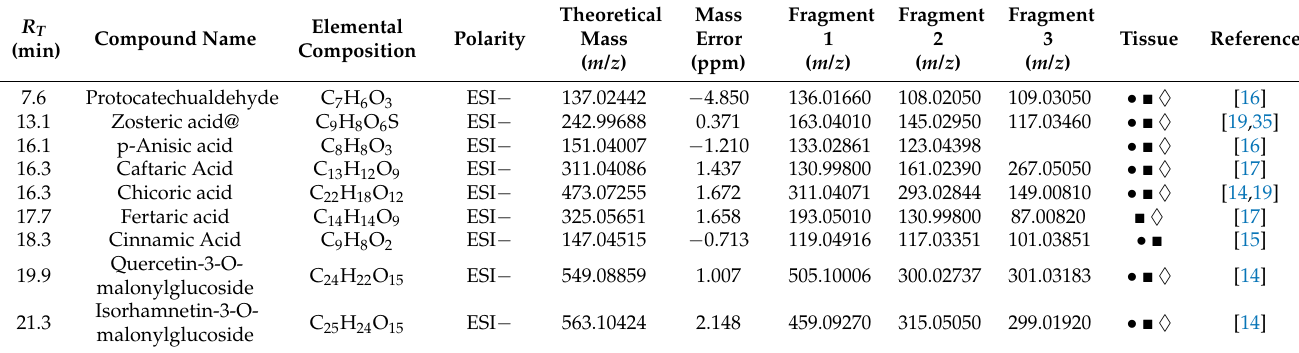
Table 2. Retention time ( R T ) and m/z ions of the detected suspected compounds in the Orbitrap system for P. oceanica and other Mediterranean seagrasses (@): Cymodocea nodosa and Zostera marina and Zostera noltii . Compounds detected in P. oceanica roots ( • ) rhizomes ( (cid:4) ), and/or leaves ( ♦